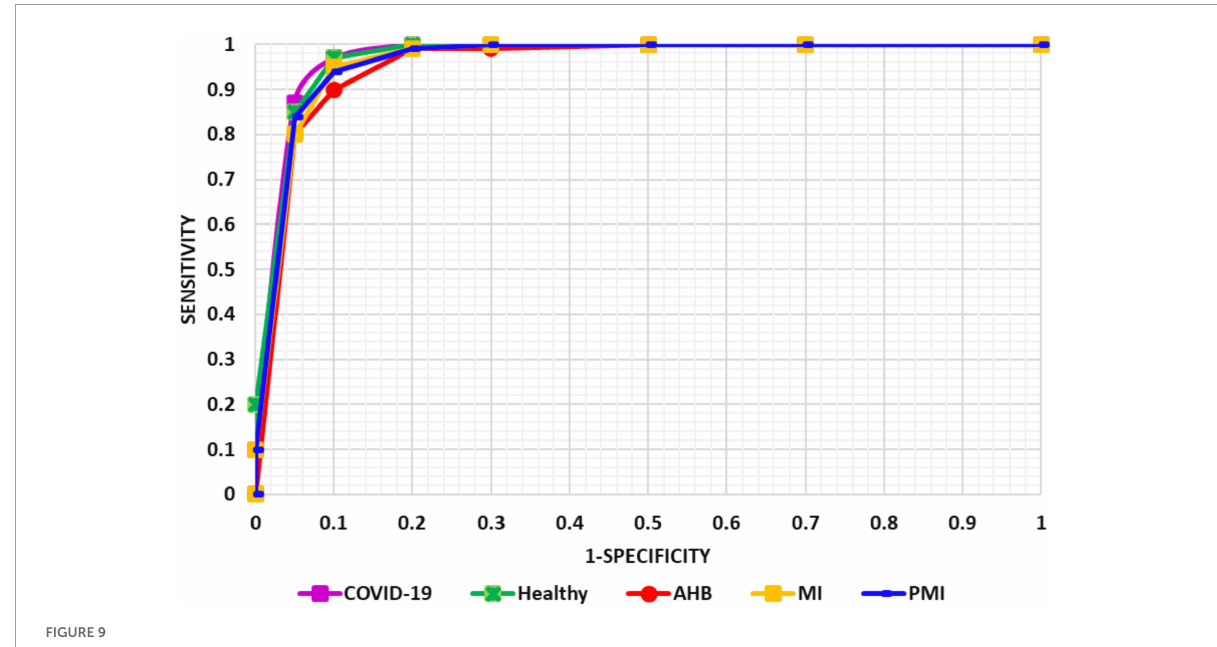
FIGURE9 Evaluation through AUC